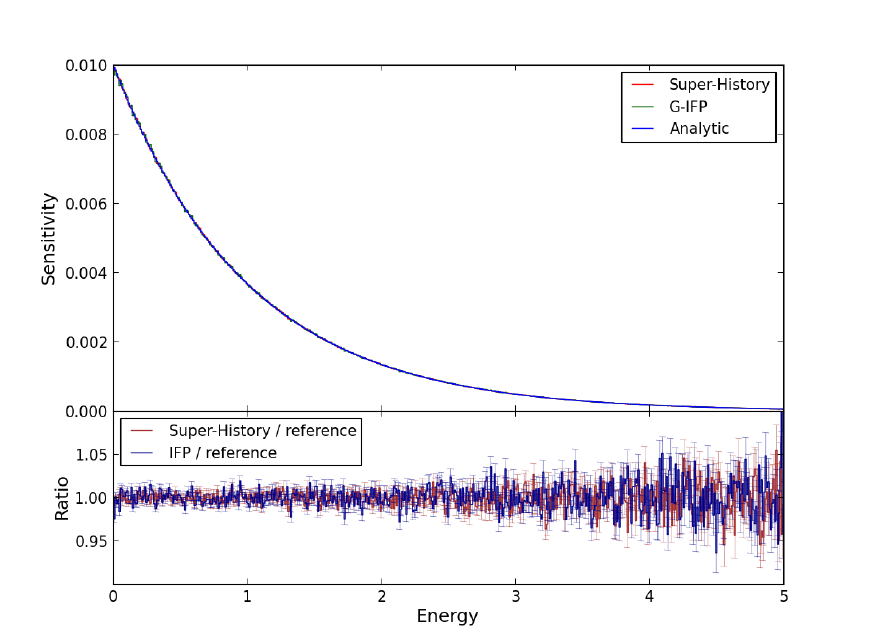
Figure 2: Sensitivity profile S ( E ) to the capture cross section computed using the G-IFP α, Σ c (red) and the super-history (dark green) methods. The analytical solution (blue) is also displayed for